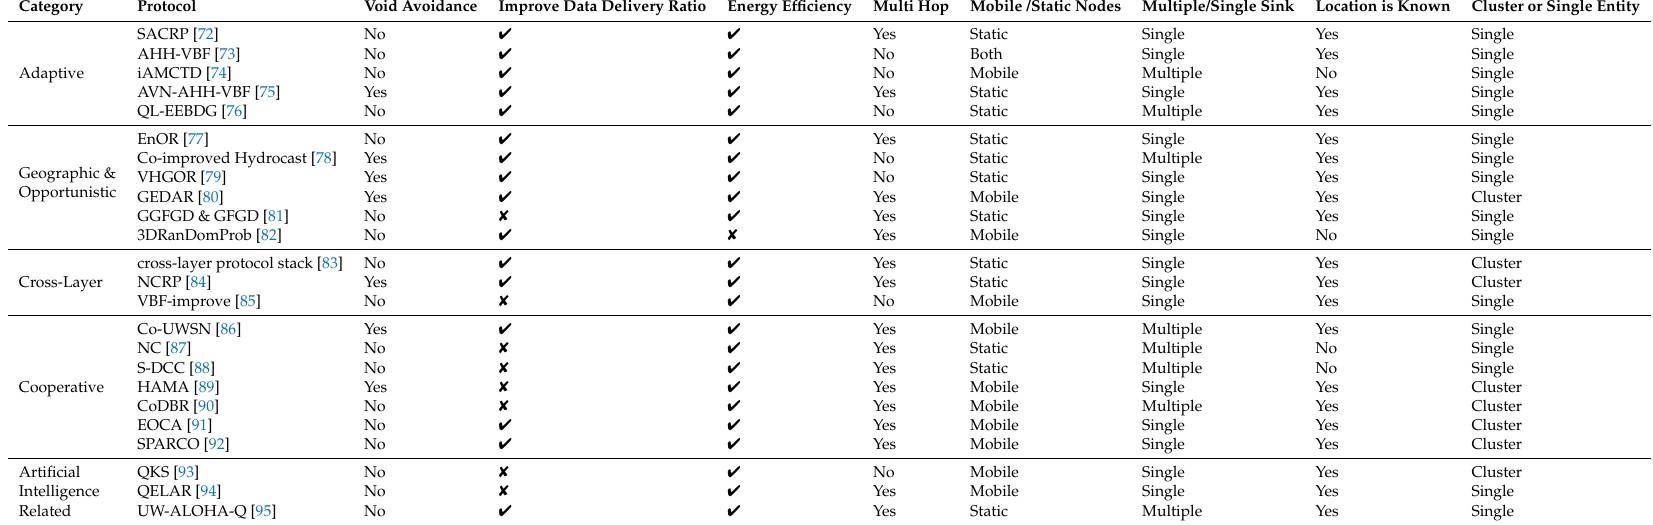
Table 6. Category of Routing Protocols Based on